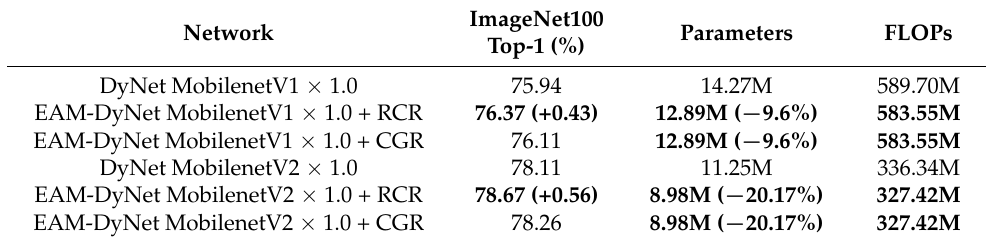
Table 2. The parameter value and FLOPs value of MobilenetV1 and MobilenetV2 in ImageNet100.